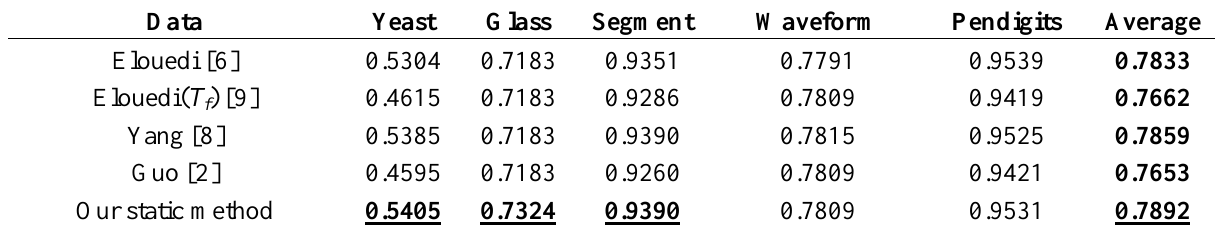
Table 9. Correct classification rates of five methods using static discounting factor.